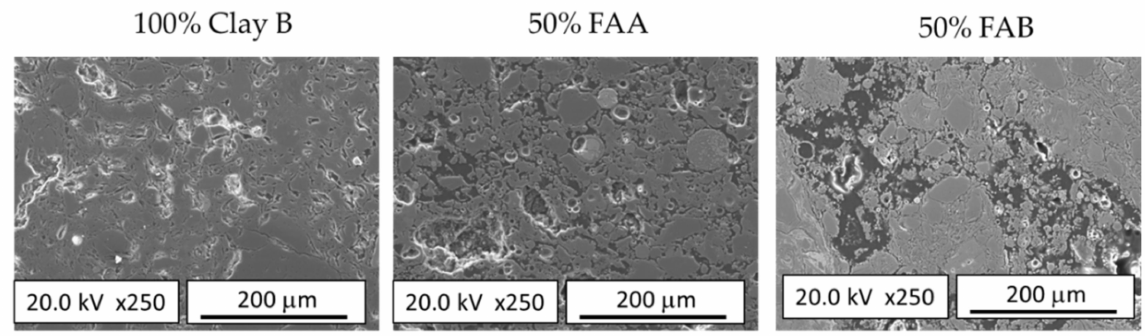
Figure 9. FESEM images of 100% clay B and 50% FAA and FAB/clay B fired clay bricks. The incorporation of fly ash into the brick composition affects not only the porosity of the fired pieces but also their crystalline composition and the distribution of crystalline phases. Figure 10 presents the FESEM images of polished and etched fracture surfaces of samples of 100% clay B and 50% FAB/clay B compositions, together with the mapping of the elements Al, Si, K, Ti, Fe, and Ca. The different crystalline phases that comprise the mineralogical composition of the fired bricks were clearly distinguished by the colour differences caused by the varying concentrations of these ions in each of the crystalline phases. The 100% clay B sample shows the conventional phase distribution in traditional fired clay materials composed mainly of quartz grains embedded in a ceramic matrix enriched in aluminium